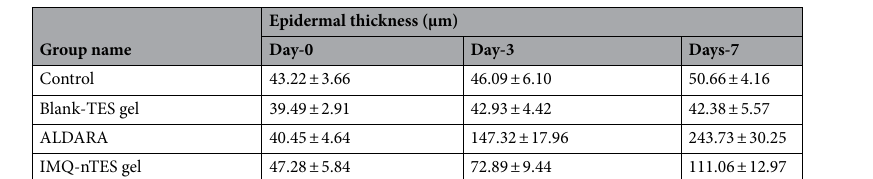
Table 6. Epidermal thickness of ALDARA, IMQ-nTES gel, and control group dissected skin, evaluated using ImageJ software. All values are mentioned as a mean ± S.D (n =